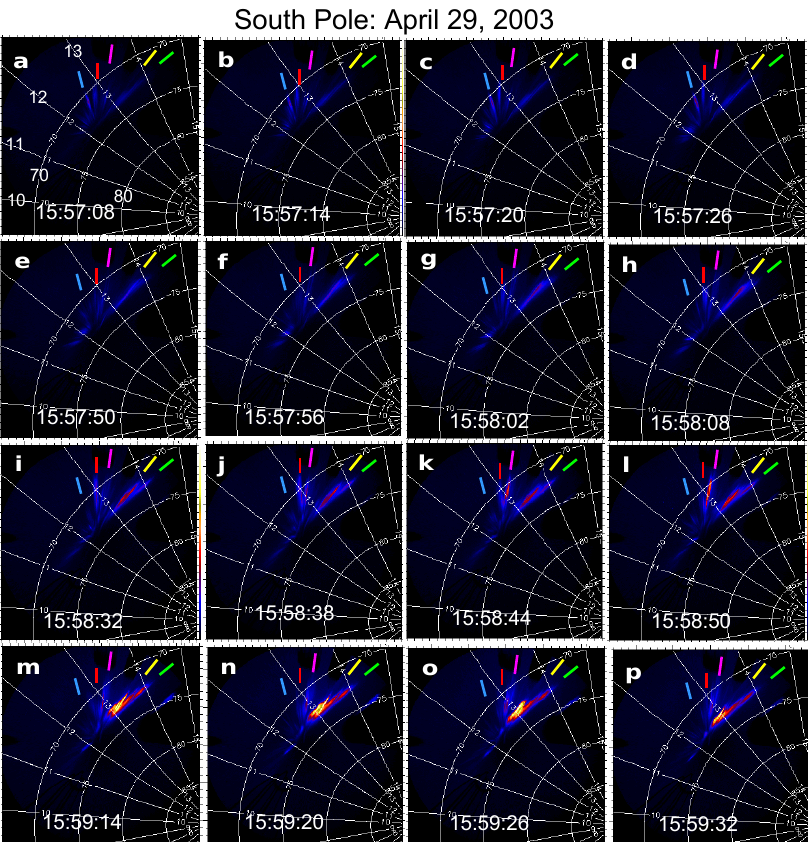
Fig. 5. South Pole Station all-sky images at 557.7nm in the format of Fig. 1. In each row the images are 6s apart. Between the last image of a row and the first image of the next row, there is a gap of 24s while the camera was recording at other wavelengths. Five different colored fiducial marks have been placed at the same point in each image to help the eye follow temporal variations at particular locations. log of the magnetic field magnitude. Green and black indi- cate regions of low magnetic-field strength where merging is expected. Last closed field lines are traced from each iono- sphere and combined into a 3-D surface in GSE coordinates. The GSE X axis is indicated by the + symbol. The inter- section of the XY plane at Z =6.9 R E with the XZ plane at Y = − 5.2 R E pinpoints the location of